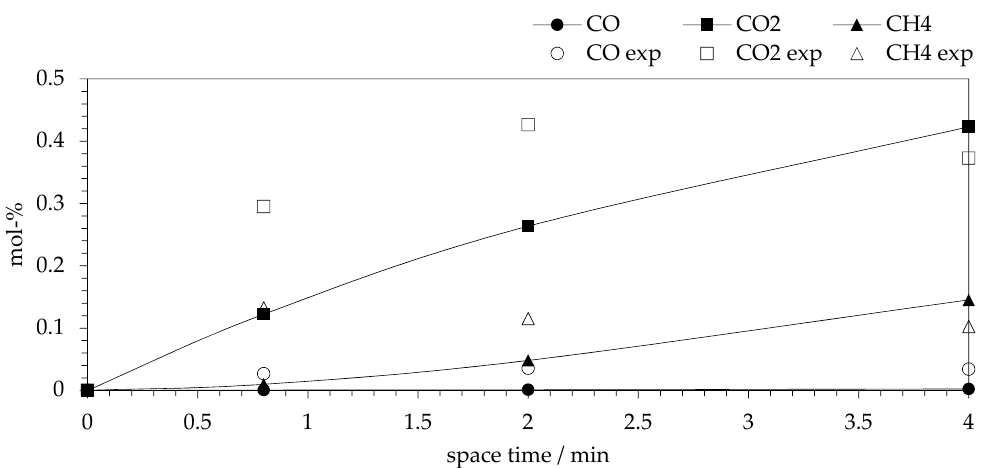
Figure 5. Experimental (empty symbols) and calculated (connected full symbols) molar concentrations of CO (sphere), CO 2 (cube) and CH 4 (triangle) at 230 °C, 3.2 MPa and different reactor space-times.